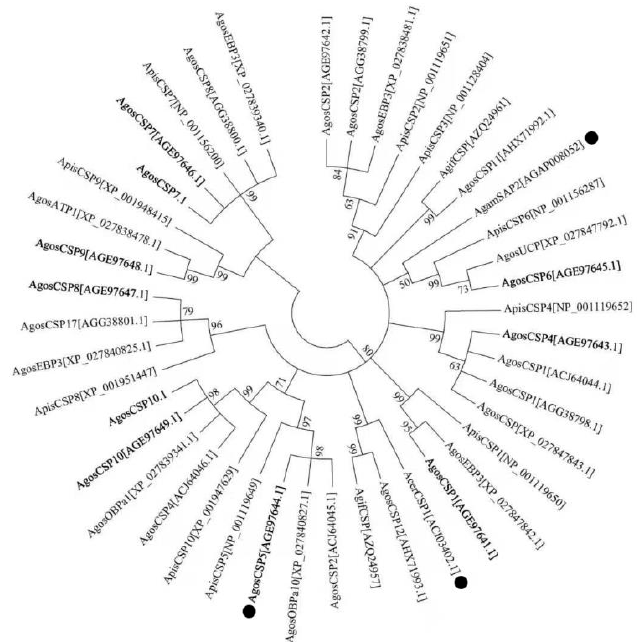
Figure 1. Phylogenetic tree for aphid chemosensory proteins (CSPs) constructed using the maximum likelihood method with 1000 replicates. The bootstrapping values of replicate trees with the associated clustering are shown at each node. The CSPs that were identified in the cotton aphid population used by the current study are in bold. AgosCSP2 and AgosCSP3 were not identified from this cotton aphid population. CSPs identified from five cotton aphid populations (this study; Gu et al., 2013 [12]; Xu et al., 2009 [13]; Li et al., 2013 [deposition in the National Center for Biotechnology Information (NCBI)]; and Quan et al., 2019 [29]) were used. The CSPs that have been shown to involve in insecticide binding and resistance, AgamSAP2, AcerCSP1 and AgosCSP5 are indicated by black dot. Agos: A. gossypii , Apis: A. pisum , Acer: Apis cerana , Agif: Aphidius gifuensis ; Agam: Anopheles gambiae . CSP: chemosensory protein; ATP1: allergen Tha p 1-like; EBP3: ejaculatory bulb-specific protein 3-like; OBPa10: odorant-binding protein A10. UCP: uncharacterised